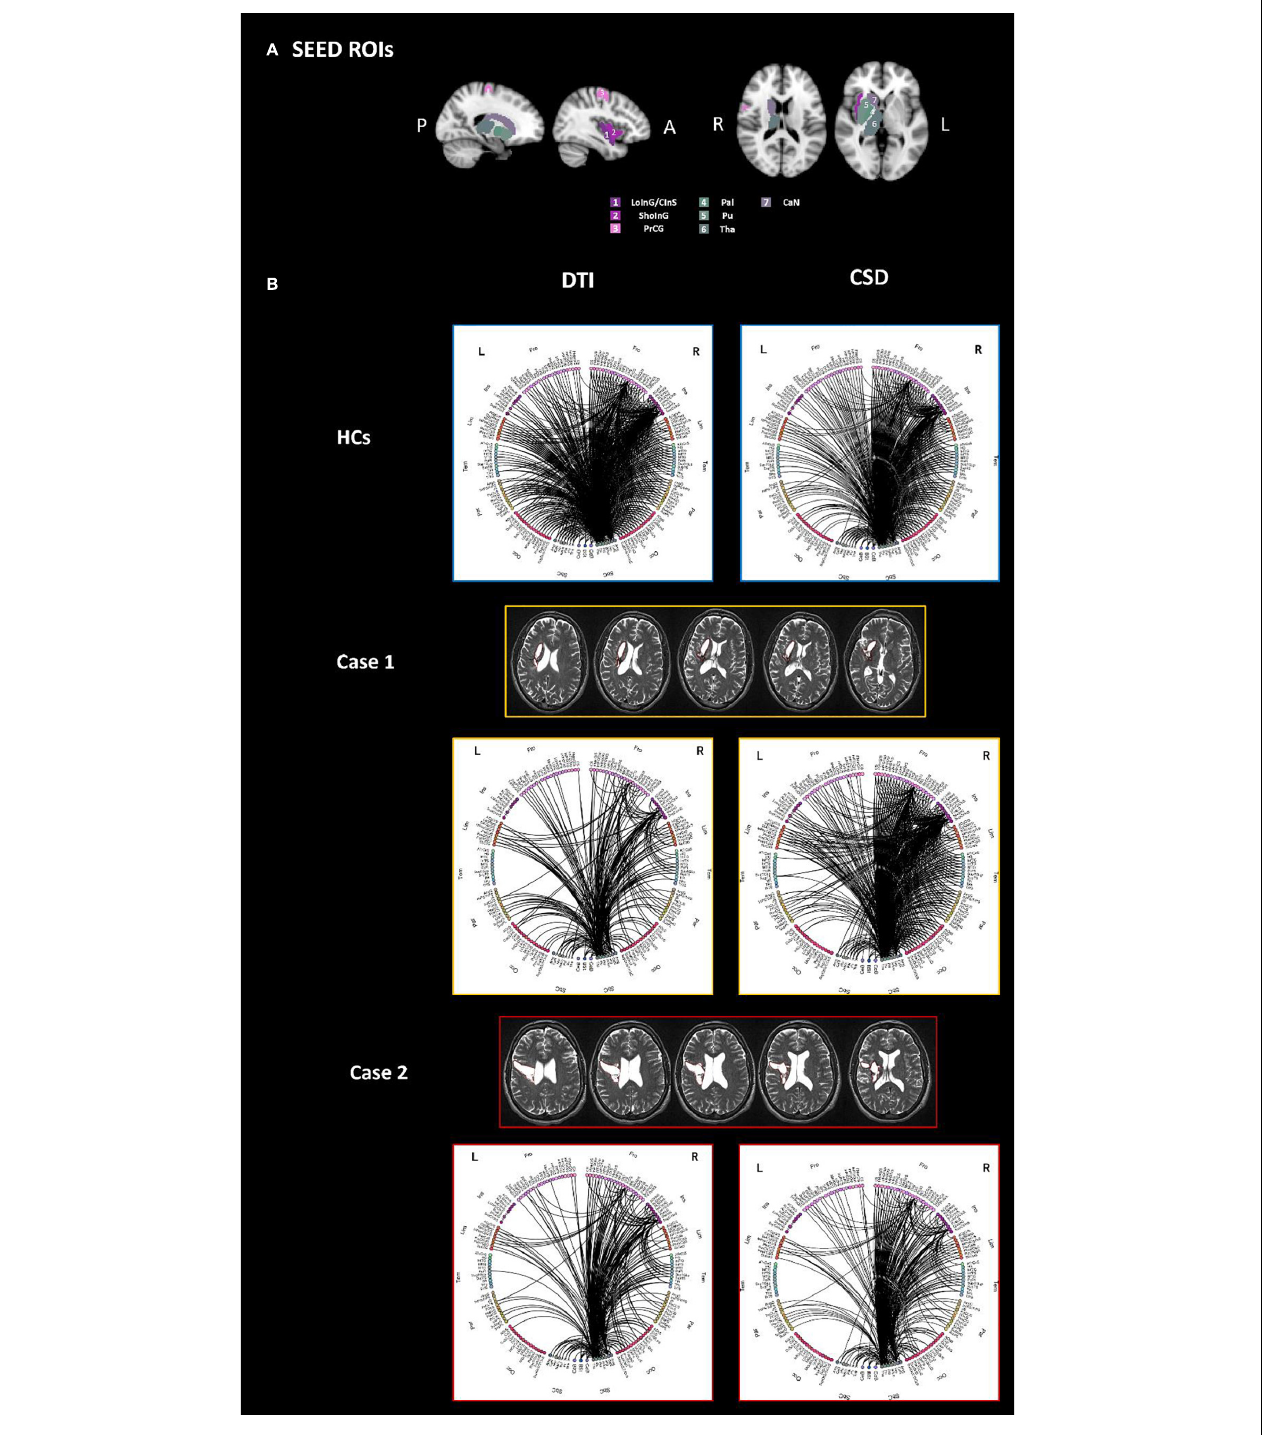
FIGURE 3 | The connectograms (B) derived by both DTI (left) and CSD (right) processing, of the sub-network extracted using as seeds all parcels which are overlapped with the stroke lesion of either Case 1 or Case 2, are reported for HCs (top panel), Case 1 (middle panel) and Case 2 (bottom panel). Specifically, seeds were defined as follows: right LoInG/CInS, right ShoInG, right Pal, right Pu, right CaN, right PrCG, right Tha (A) . All the other parcels of the brain were considered as target for the connectivity analysis. L-left hemisphere, R-right hemisphere, Fro-frontal, Ins-insular, Tem-temporal, Par-parietal, Occ-occipital, Sbc-subcortical, CeB-cerebellum, Bst-brainstem, PrCG-precentral gyrus, LoInG/CInS-long insular gyrus and central insular sulcus, ShoInG-short insular gyri, Pal-pallidum, Pu-putamen, CaN-caudate nucleus, Tha-thalamus.